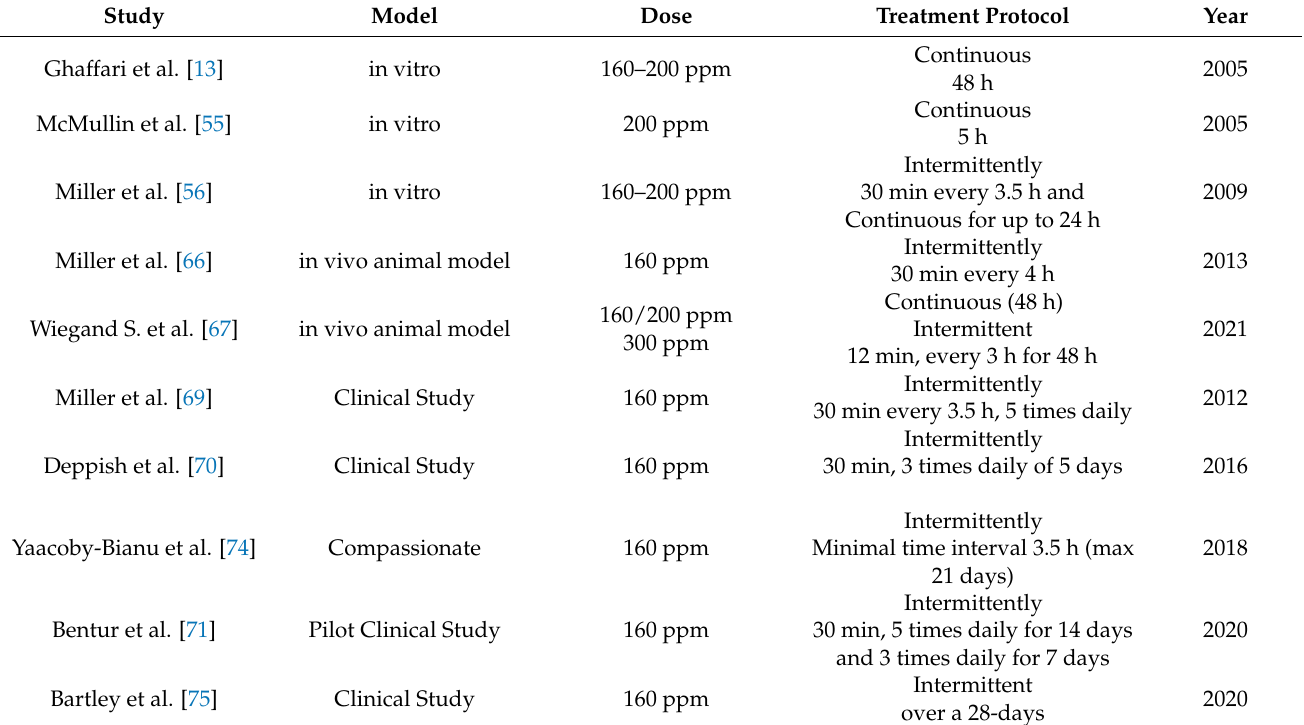
Table 1. Experimental selected protocols of antibacterial high-dose nitric oxide